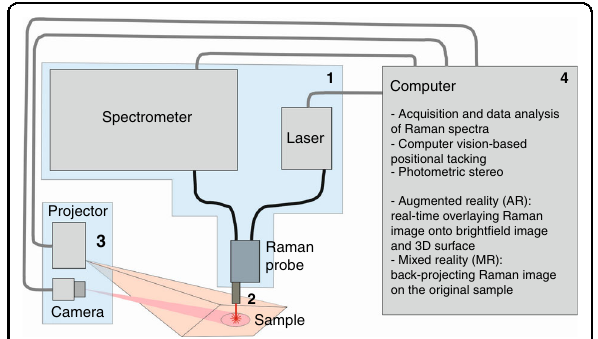
Fig. 1 Schematic of a fi ber-guided Raman system combined with augmented reality (AR) and mixed reality(MR) for real-time opto- molecular visualization of tissue boundaries for clinical